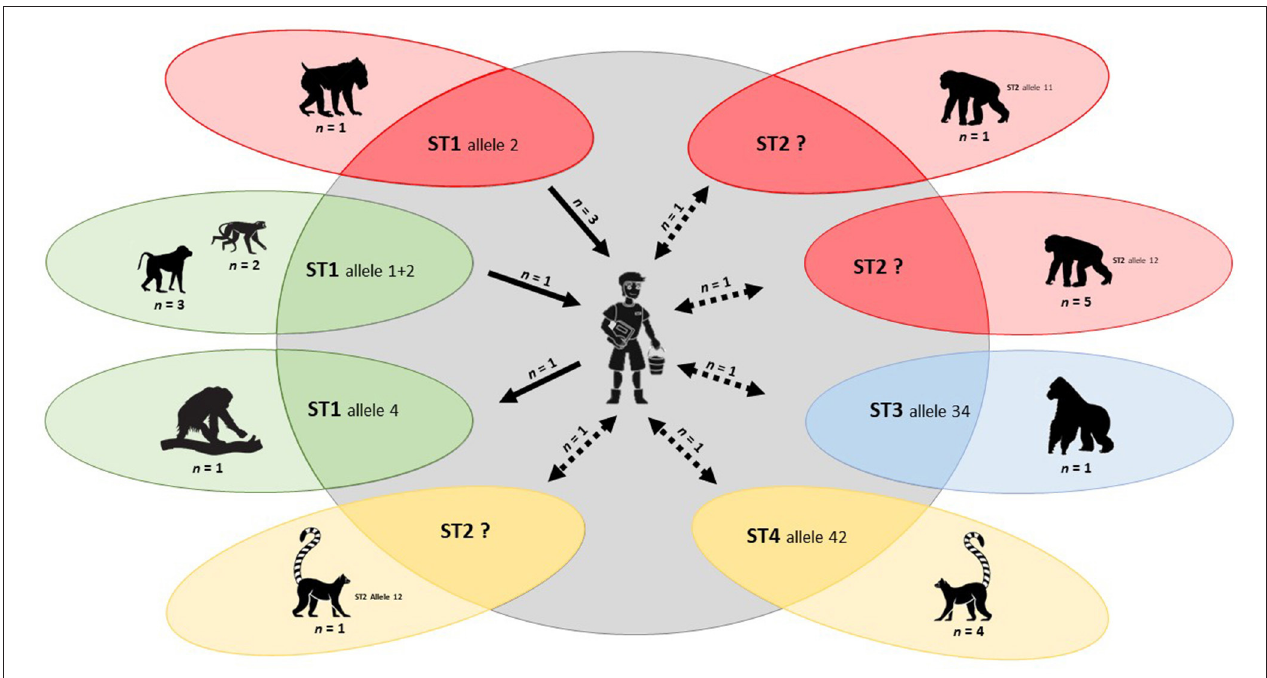
FIGURE 3 | Molecular-based evidence of Blastocystis zoonotic transmission between captive NHP and their zookeepers in the present study. Individual zoological institutions where transmission events were detected are identified in different colours. Solid arrows represent zoonotic transmission events for which directionality (human-to-animal or animal-to-human) is well-established. Discontinuous arrows represent zoonotic transmission events for which directionality is